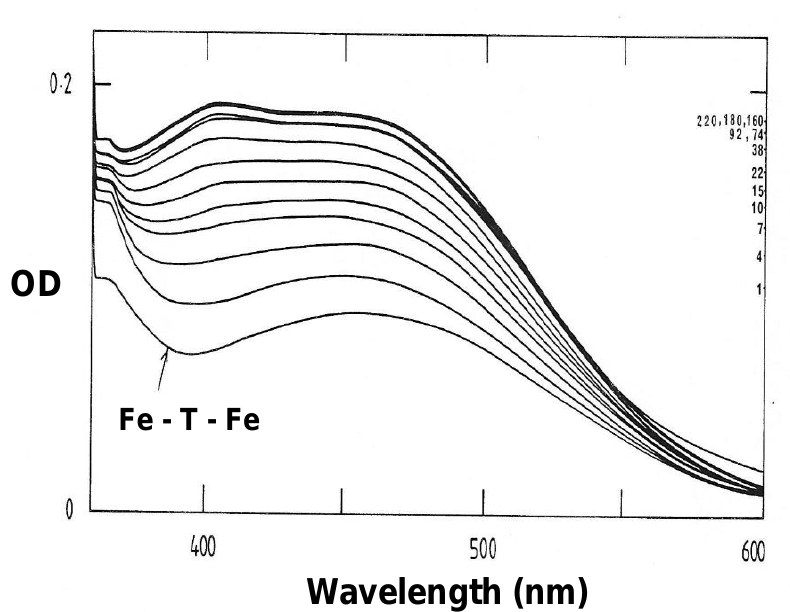
Figure 5. The interaction of maltol with iron saturated transferrin. Optical density (OD) spectral changes of the reaction of maltol (1.0 mM) with diferric transferrin (Fe-T-Fe) (0.036 mM) as a function of time from 1 – 220 min [25].